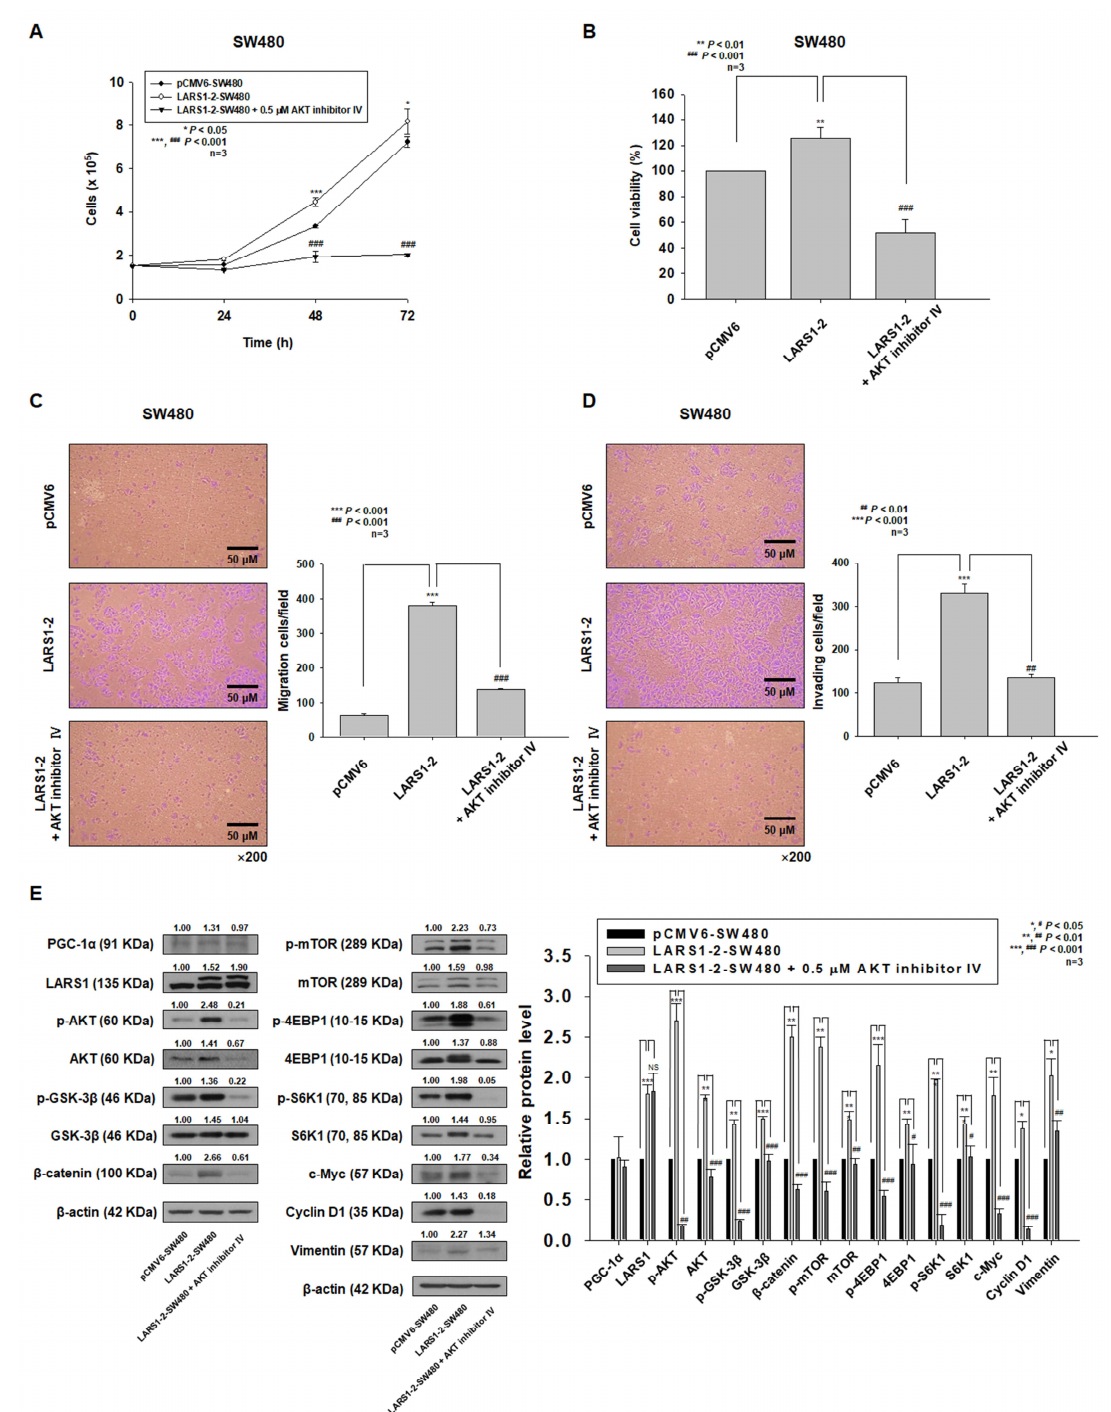
Figure 6. LARS1 enhances cell proliferation, migration, and invasion through AKT activation in SW480 cells. ( A , B ) LARS1-2-SW480 cells were treated with/without 0.5 µ M AKT inhibitor IV for indicated time ( A ) or for 48 h ( B ) and cell proliferation was measured by cell counting ( A ) and